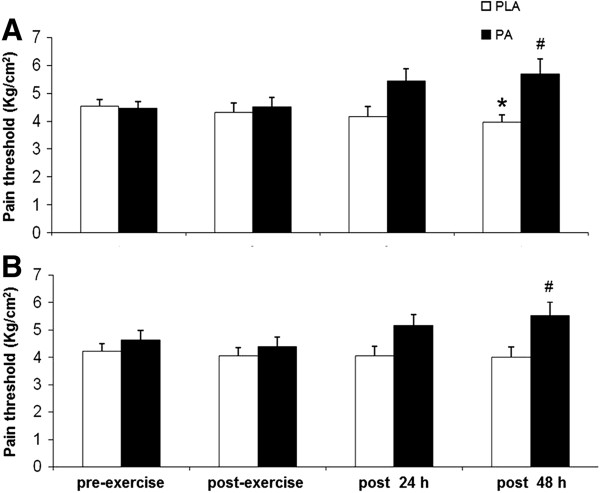
Levels of pain threshold on the right leg (A) and left leg (B) before exercise (pre-exercise), immediately after (post-exercise), and 24 h (post 24 h) and 48 h (post 48 h) after high-intensity exercise. Values are presented as mean ± SE (n = 12). PLA, placebo. *Significantly different from before exercise (p < 0.05), #significantly different from the PLA group at the same time point (p < 0.05).